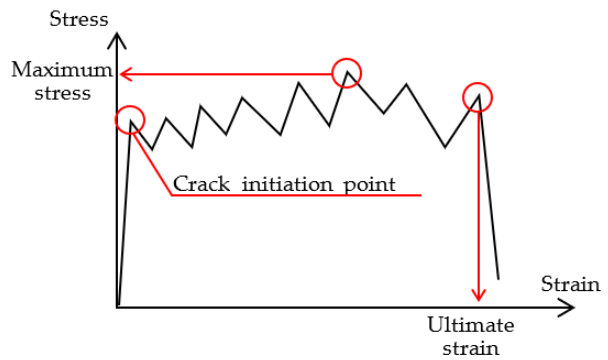
Figure 4. Definition of maximum strength and ultimate strain.